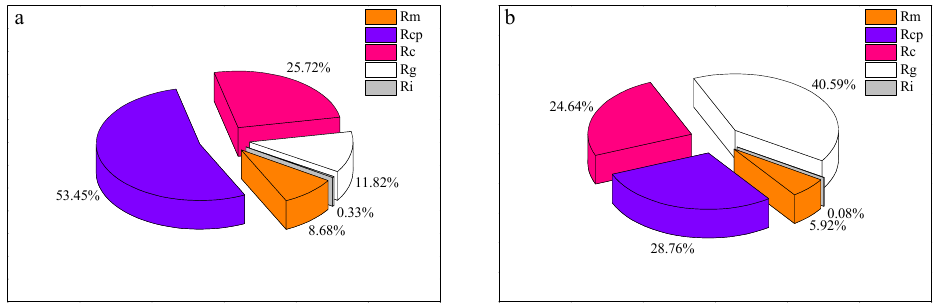
Figure 5. The membrane resistance distribution after 45 d in MBR. ( a ) Immersed the HTR-PVDF membrane in critic acid (20 min) + NaClO (20 min). ( b ) Immersed the HMR-PVDF membrane in critic acid (60 min) + NaClO (60 min). Table 4. The flux changes of the HTR-PVDF and HMR-PVDF membrane after 45 d in MBR. Items